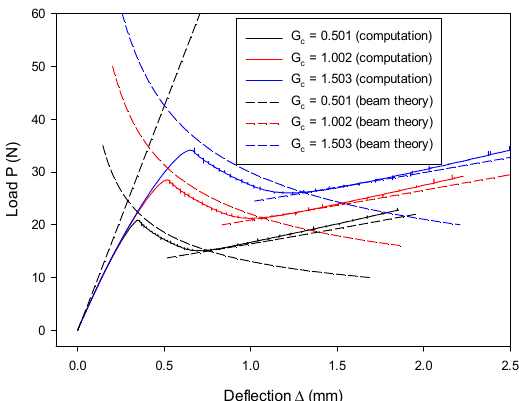
Figure 26. Load–deflection (P ∼ ∆ ) histories in the MMB model ( β = 50%) vary as a function of critical energy release rate G c